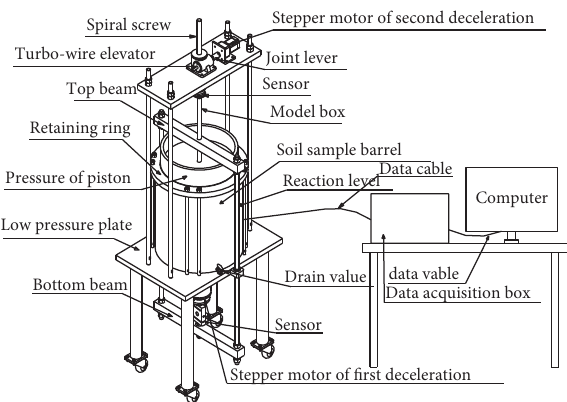
Figure 1: Schematic diagram for the model device.